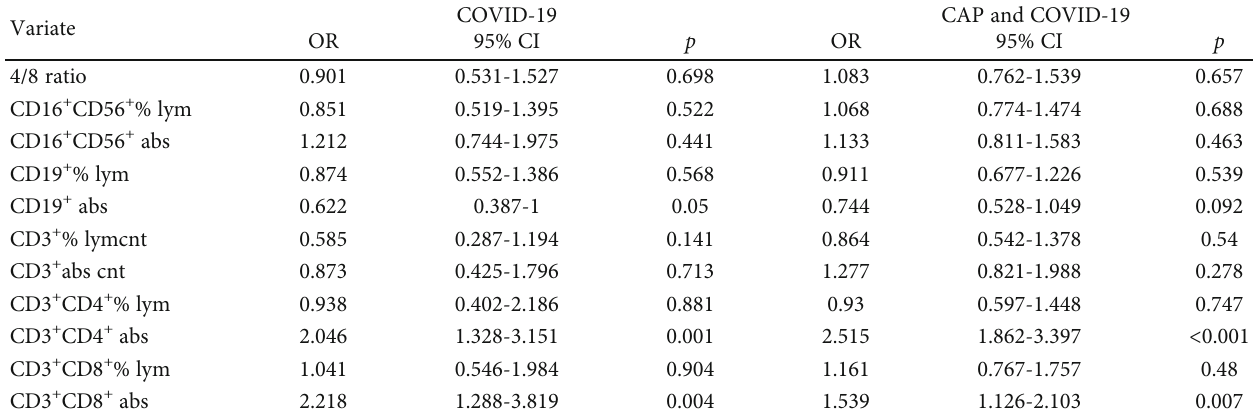
Table 4: Multivariate predictors of lymphocyte subsets on disease